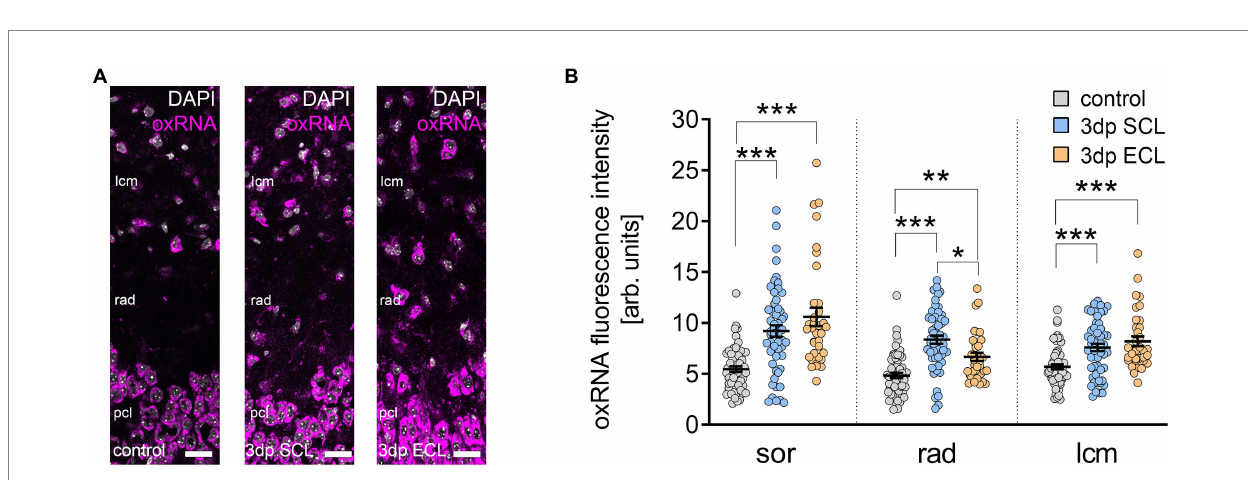
FIGURE 7 Lesion is accompanied by oxidative RNA modifications in CA1 dendritic layers. (A) Representative sample images of the CA1 region of tissue culture controls and 3 days after either SCL or ECL, stained with DAPI nuclear stain and a marker for oxidative RNA modifications. Scale bar, 25 μ m. (B) The amount of oxidative RNA modifications was significantly increased after both SCL and ECL in all layers of CA1 neurons (n control = 60 visual fields in 12 cultures, n SCL = 55 visual fields in 11 cultures, n ECL = 35 visual fields in 7 cultures, Kruskal-Wallis test followed by Dunn’s posthoc correction). Individual data points are indicated by colored dots. Values represent mean ± s.e.m. (* p < 0.05, ** p < 0.01, *** p <